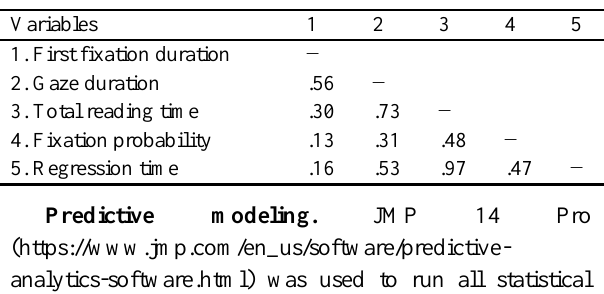
Table 3 . Correlations between Five Common